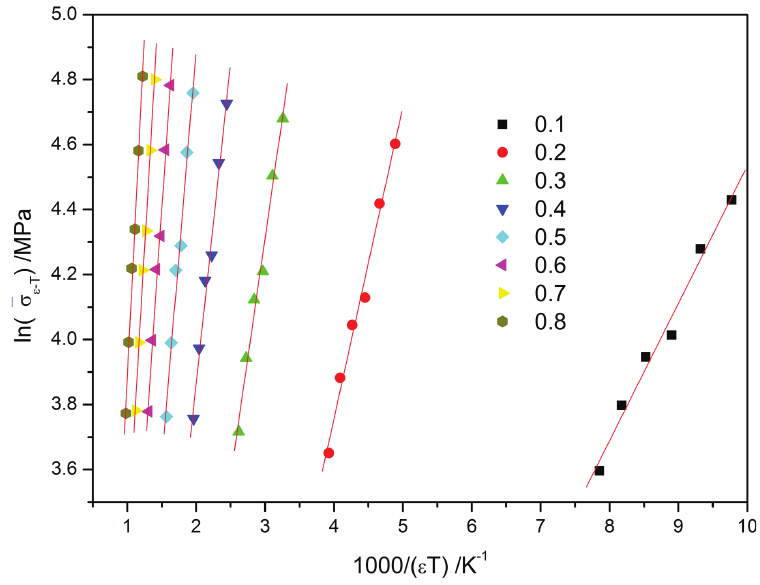
Figure 12: Relationship between ln ð (cid:2) σ ε − T Þ and 1000 = ð ε T Þ .